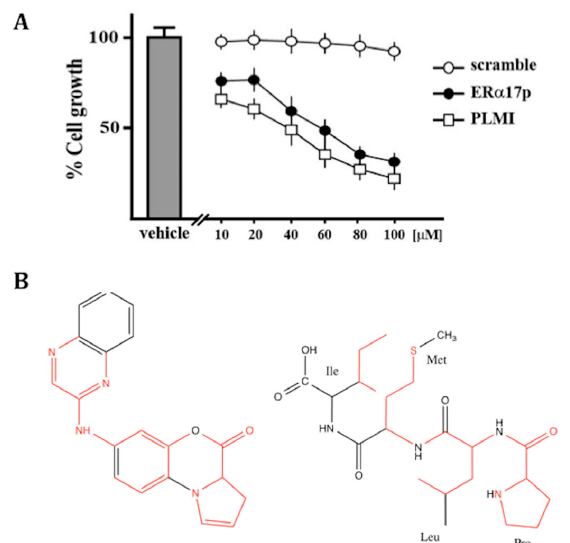
Figure 7. ( A ) The tetrapeptidic sequence PLMI inhibits the growth of breast cancer cells. SkBr3 cells were treated for 72 h with increasing concentrations of the scramble peptide (control), the ER α 17p or the PLMI tetrapeptide. Cell viability is expressed as the percentage of cells upon exposure with ER α 17p or PLMI with respect to cells treated with the scramble peptide (control). Values are mean ± SD of three independent experiments performed in triplicate. ( B ) Structural analogies (in red) between the GPR30 antagonist PBX1 (left) and the ER α 17p-derived peptide motif PLMI (right).